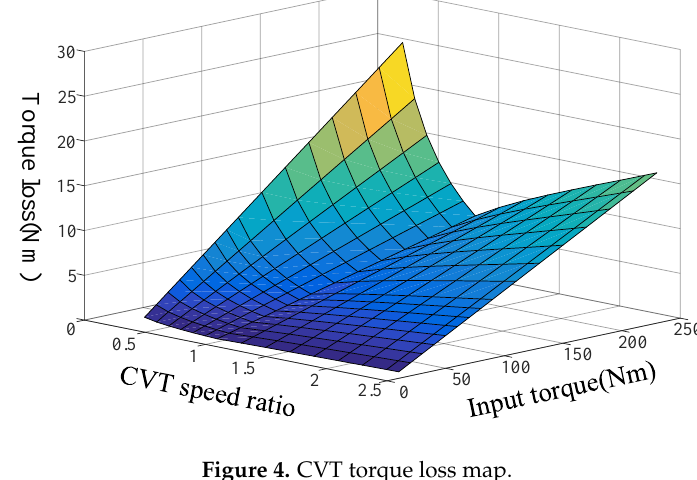
Figure 4. CVT torque loss map.